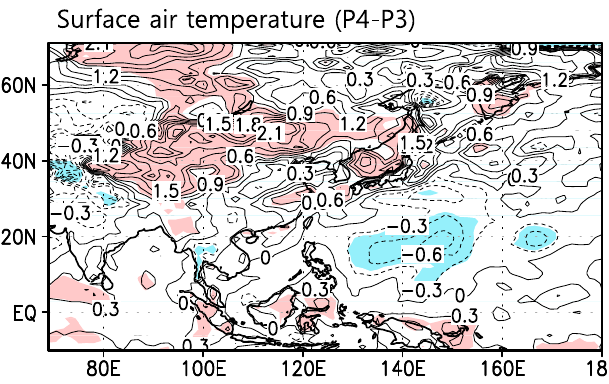
Figure 7. Composite differences of summertime surface air temperature (Unit: °C) of the periods P4 and P3. The values in the shaded area are significant at the 90% confidence level with the Student’s t - test.